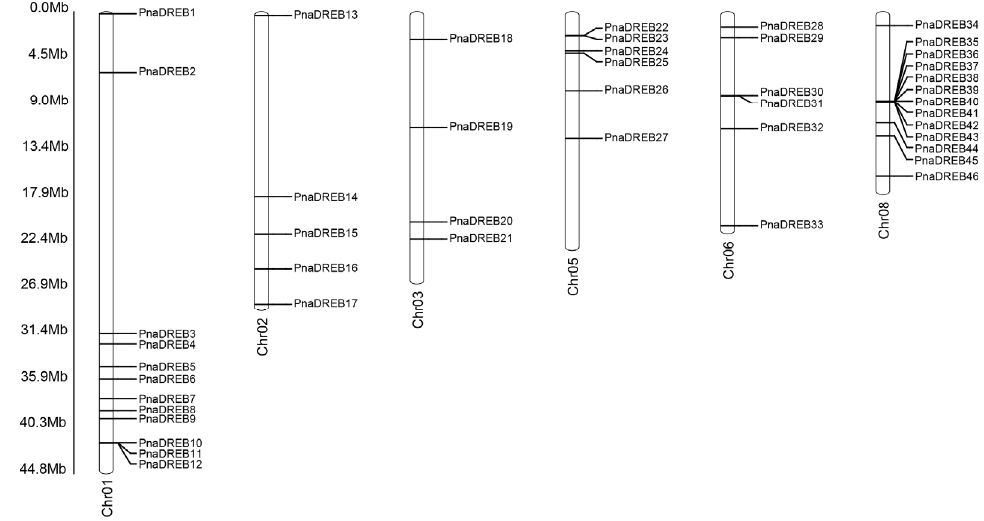
Figure 1. PnaDREB gene distributions across six P. dulcis chromosomes.